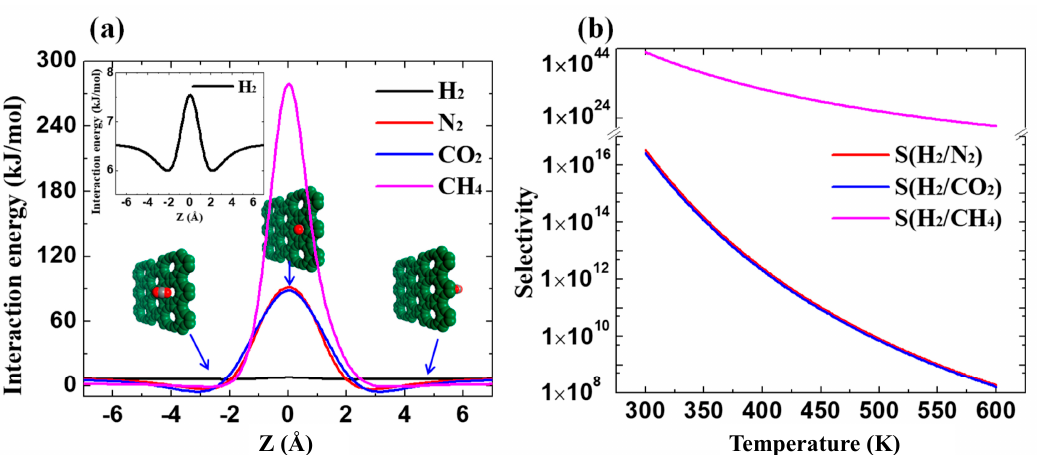
Figure 4. DFT calculations of gases crossing the membrane of GDY_2.1Å. ( a ) Minimum energy pathways of four gases. ( b ) Ideal selectivities of H 2 over N 2 , CO 2 , and CH 4 as functions of temperature.